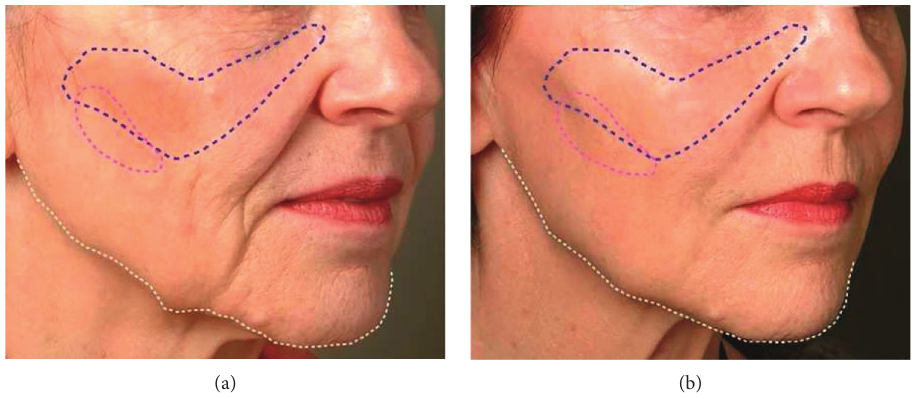
Figure 3: (a) 67 year-old patient shows multiple signs of aging due to loosening of the soft tissues in several areas, such as sagging in the mid and lowerface, andresorption of the upper and lower jaws. (b). The patient’s face 10 months after hyaluronic acid injection. No surgery was performed. The changes are due to providing prominence or lift, restoring the structure and volume to the cheek mound and mid-cheek (marked in blue), weakening the shadows of the cheeks (marked in purple), and repairing the borders of the mandible (marked in white)